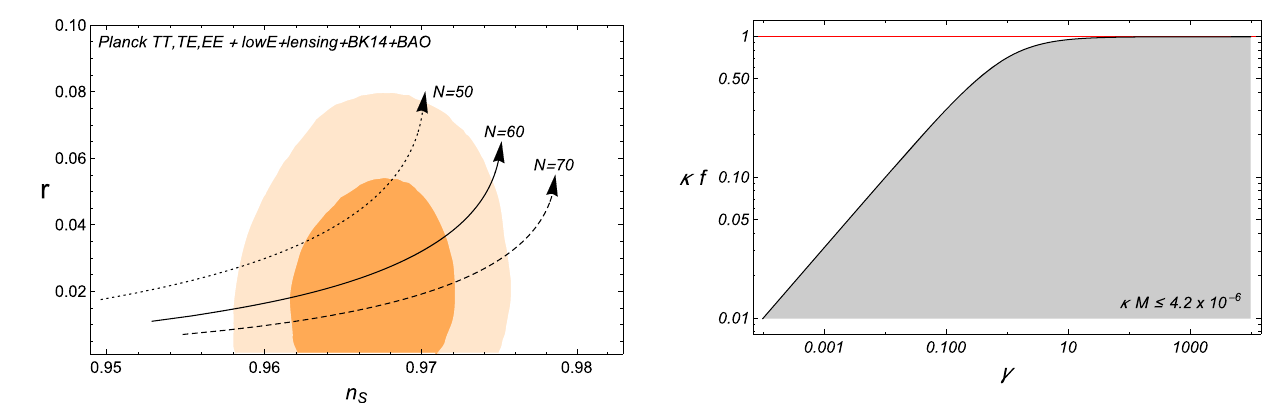
Fig. 3 Observational constraints on natural inflation. The parameter ranges between 12 ≤ α ≤ 10 3 for each dotted ( N = 50), solid ( N = 60), and dashed ( N = 70) line. The arrows indicate the increasing direction of α